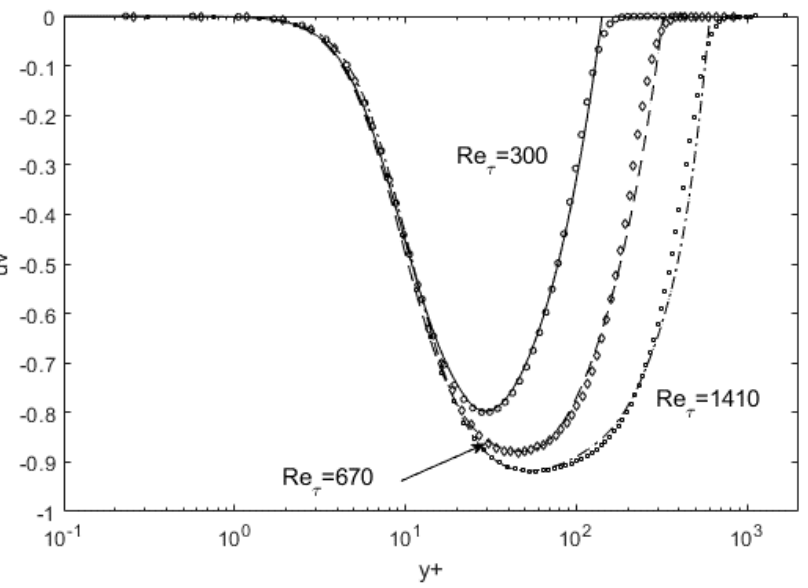
Figure 6. The Reynolds shear stress reconstructed using Equation (3) and numerical integration (lines), based on a channel-flow template at Re τ = 1000 [12]. DNS data (symbols) are for boundary- layer flow over a flat plate from Spalart [13].